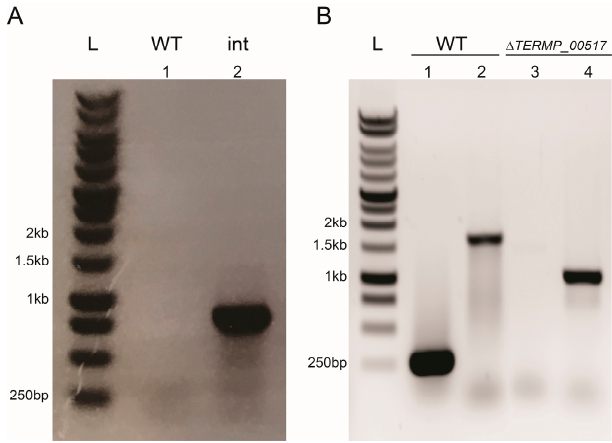
Figure 4. PCR gel migration of mutant strain constructions. ( A ) TK0664 gene amplification realized with primers XhoI-6MPK_Up and SmaI-6MPK_Do (Primer pair 1, Figure 2) to verify the genotype of pUPH after integration into the T. barophilus genome (int, well 2, 819 bp). ( B ) TERM_00517 gene amplification realized with primers Verif- ∆ 6MPB_Up and Verif- ∆ 6MPB_Do (wells 1 and 3, Primer